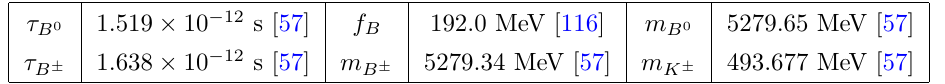
Table 26 . Input parameters for B meson